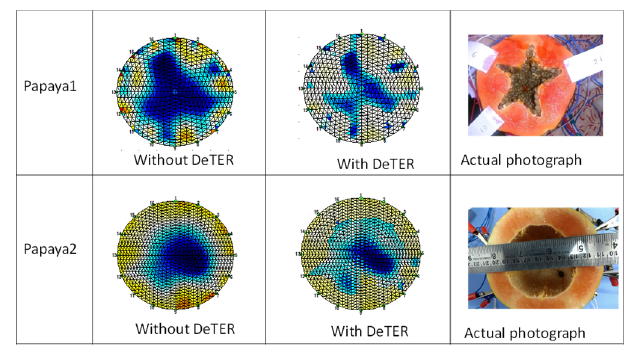
Fig.13: Reconstructed images with actual cross-sectional cuts of